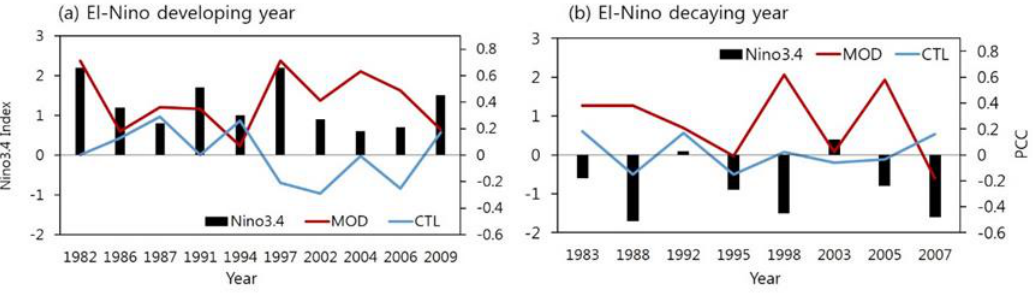
Figure 4. Same as Figure 2 except for El-Nino: ( a ) developing; and ( b ) decaying years.